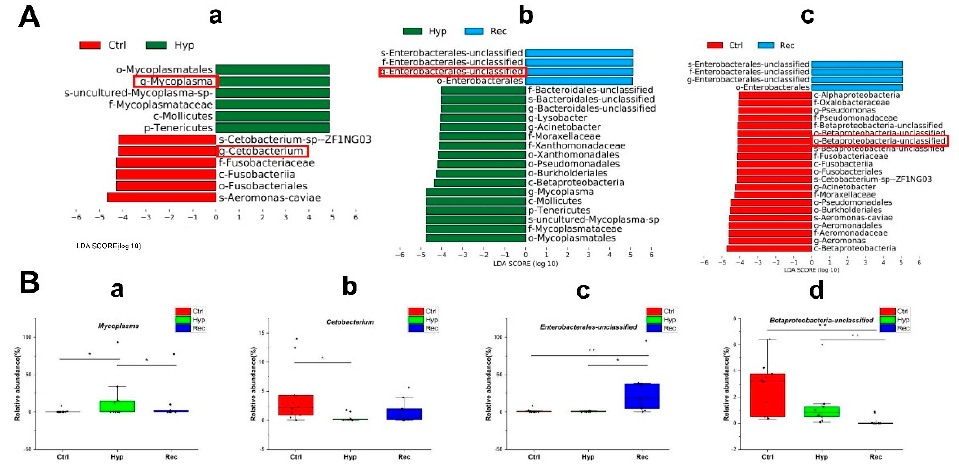
Figure 9. ( A ): Taxa shown in histogram were determined to differ significantly in abundance among Ctrl, Hyp, and Rec groups by Kruskal–Wallis test (( p < 0.05, LDA score >4, ( a ): Ctrl vs. Hyp; ( b ): Hyp vs. Rec; ( c ): Ctrl vs. Rec) ( n = 10). ( B ): Abundance of major bacteria ( a–d ) in Ctrl, Str, and Rec groups (*, p < 0.05; **, p < 0.01) ( n =